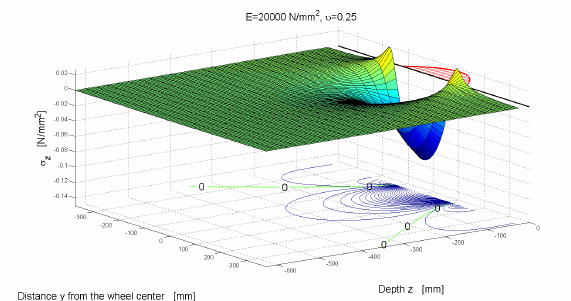
Figure 19: 3-D surface and stress contours of σ z on the A-A vertical cross-section of Figure 17, according to the second order solution.